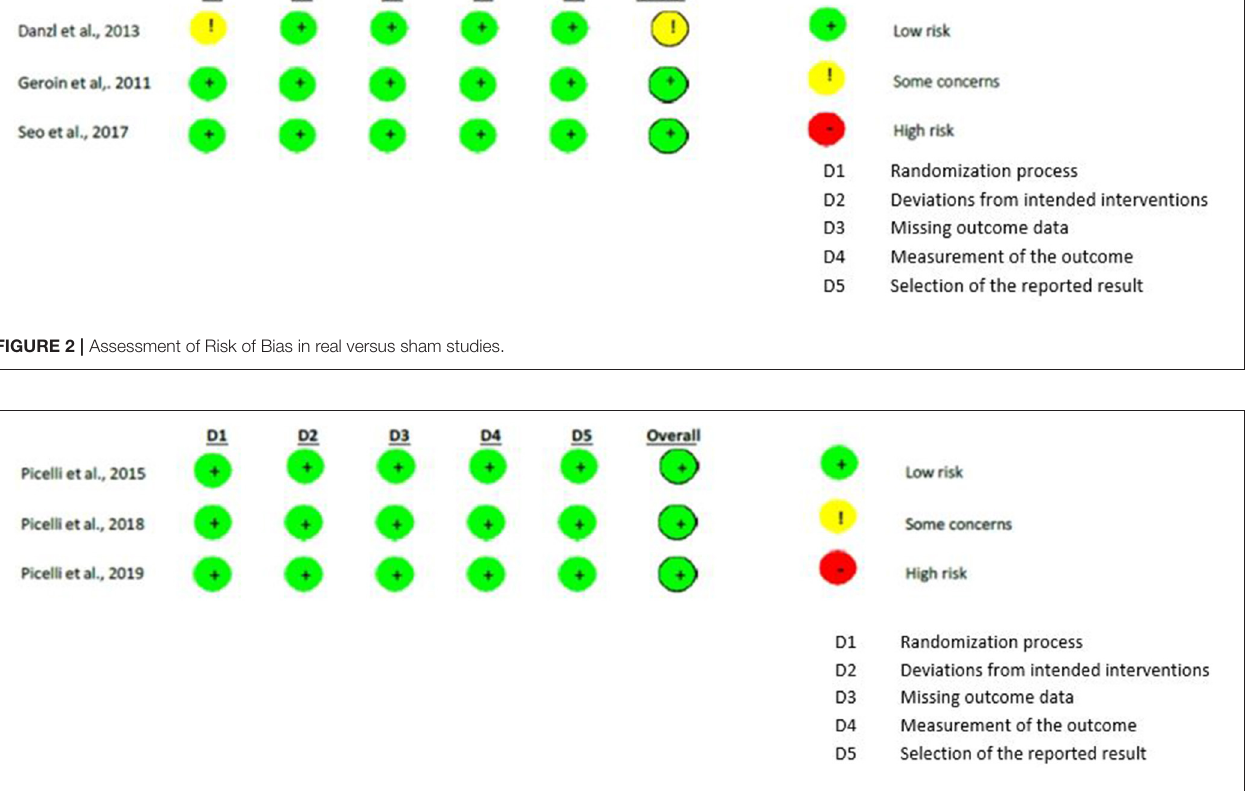
FIGURE 3 | Assessment of Risk of Bias in methodological